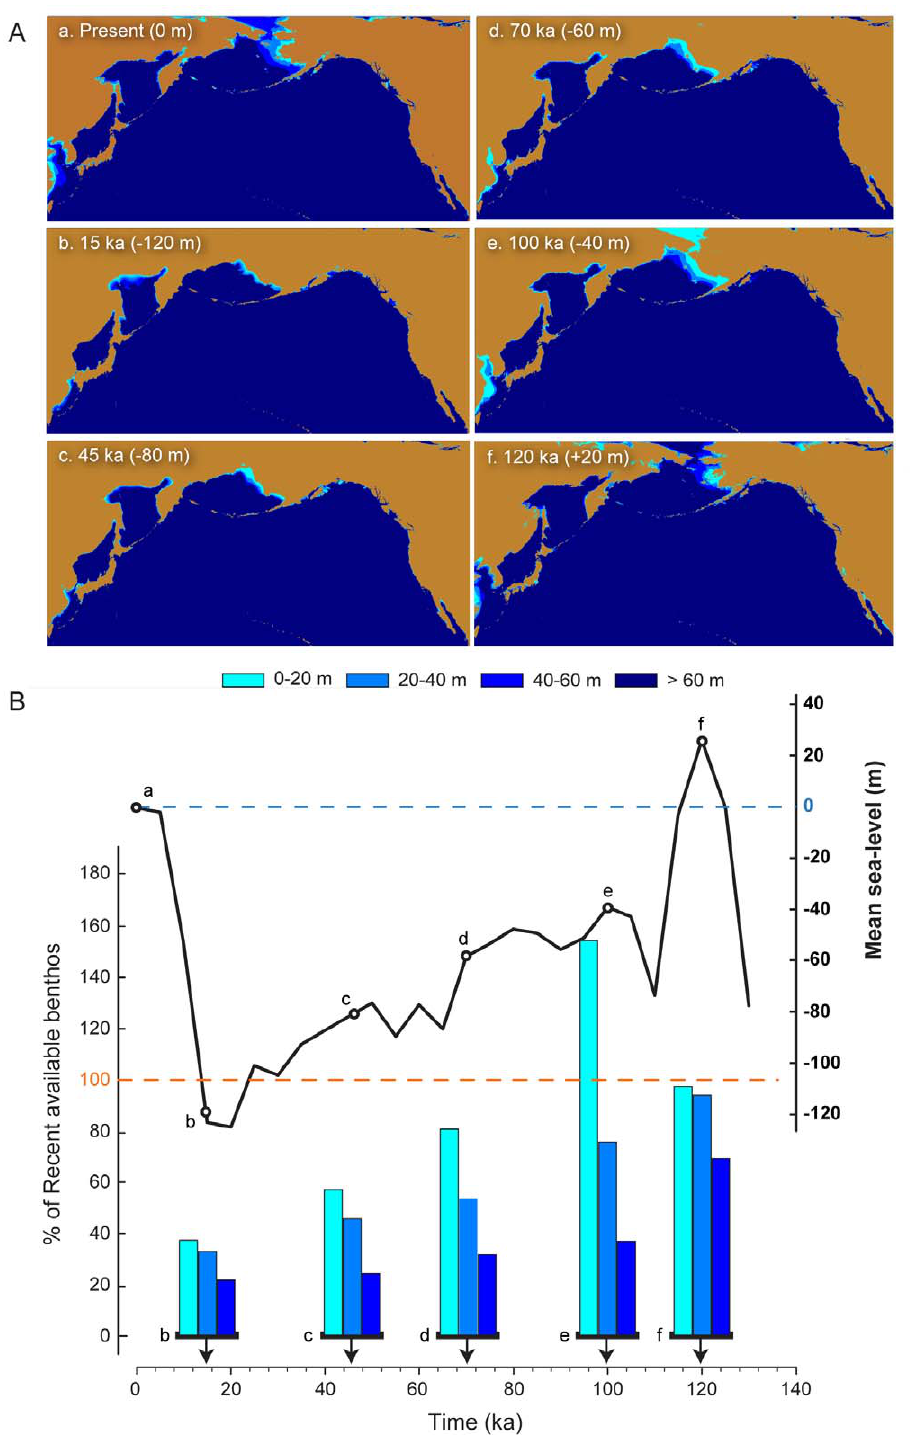
Figure 2. Benthos availability, sea-level change and coastal configuration of continental margins in the North Pacific Ocean, at select intervals, during the last 120 ka. A) Geographic plates at the top of the figure depict reconstructed coastal configurations and 20 m depth contours for (a) present day, (b) 15 ka, (c) 45 ka, (d) 70 ka, (e) 100 ka, and (f), 120 ka. See Table 1 for regional boundaries and summary data; depth data from ETOPO1 [115]. B) Left axis on the plot shows bar graphs with available benthos at 20 m increments at select time intervals (a–f). Right axis shows mean sea-level changes in past 130 ka, using data from Miller et al. [43]. Dashed lines indicate (left, in orange) current sea-level and (right, in blue) current benthos availability.